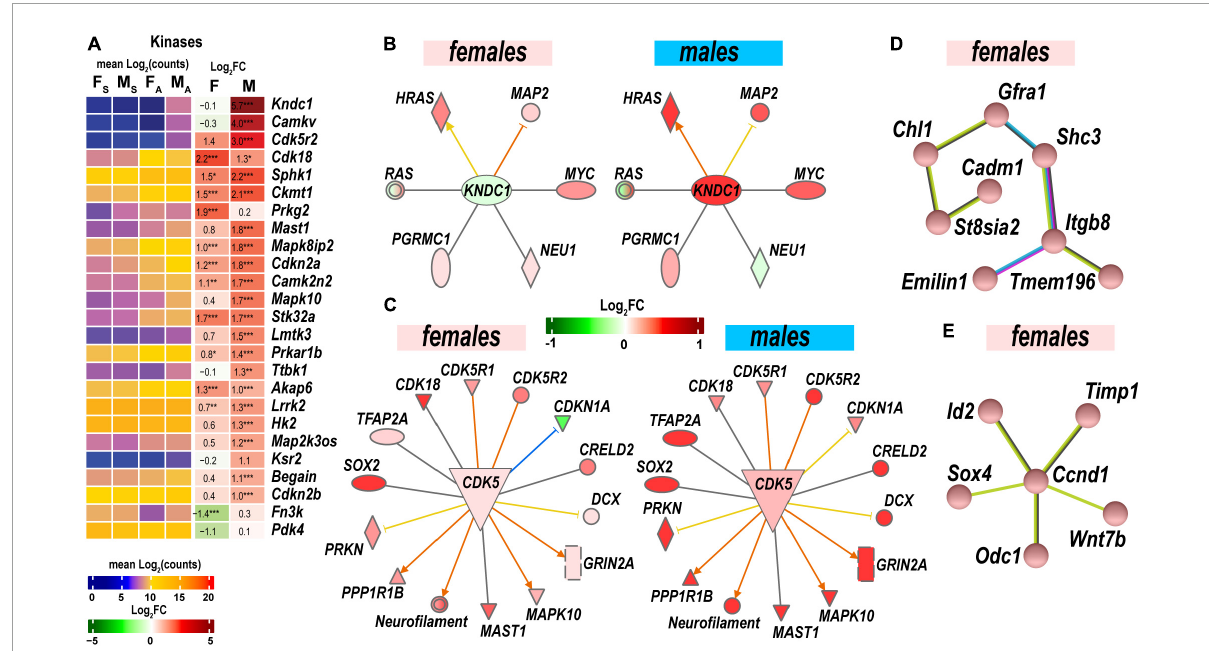
FIGURE6 Protein phosphorylation was strongly activated to regulate cell-cell adhesion and neuronal plasticity. (A) Expression of differentially expressed genes (DEGs) with kinase activities. Heatmaps display normalized mean log 2 (counts) in sample groups (F S , female sham; M S , male sham; F A , female axotomy; M A , male axotomy) and log 2 FC in female (F) and male (M); ( n = 6 mice/group, 2 mice/sample (pooled), 3 sample/group) of respective DEGs. Log 2 FC significance was determine in DESeq2 using Wald test: *, p ≤ 0.05; **, p ≤ 0.005; ***, p ≤ 0.0005. DEGs were sorted by log 2 FC. (B) RAS-Guanine nucleotide exchange factor KNDC1 links HRAS, MYC, NEU1, RAS, and MAP2. Male but not female nerves exhibit upregulation of key components. (C) Protein interaction networks regulated by CDK5 in females (left) and males (right). (D) Female-specific Gfra1/Cadm1 axis. (E) Proposed regulation by female-prevalent Ccnd1/Timp1 axis. The shape’s colors on panels B and C correspond to up- (red) or down- (green) regulation of respective DEGs according to the Log 2 FC scale. Protein interactive networks were predicted in IPA (panels B and C ) and the STRING database (panels D and E